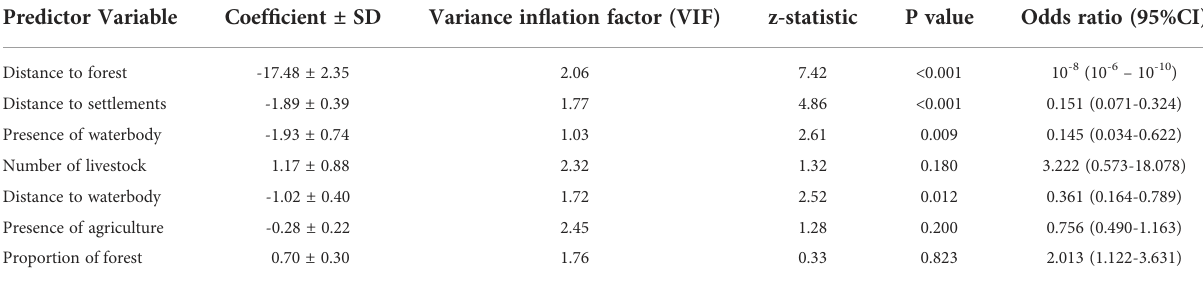
TABLE 3 Parameters of the averaged model in this study.